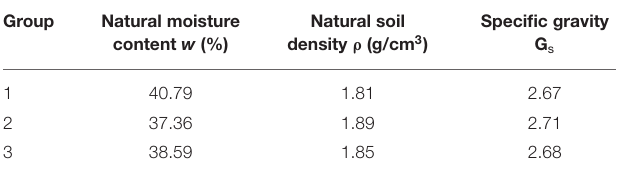
TABLE 1 | Physical properties test results.